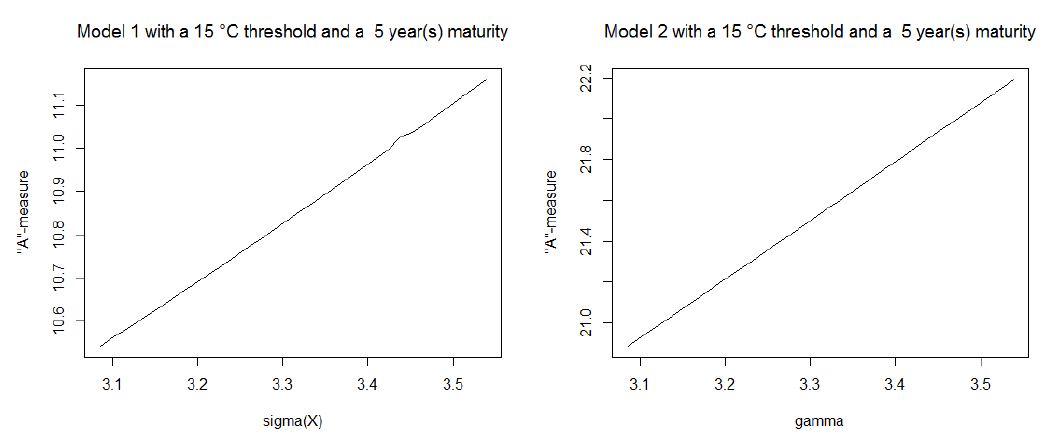
√ 9 . 521374 to for Model 1 Equation (10) (from X √ √ 9 . 521374 to 9 . 521374 + 3 ).